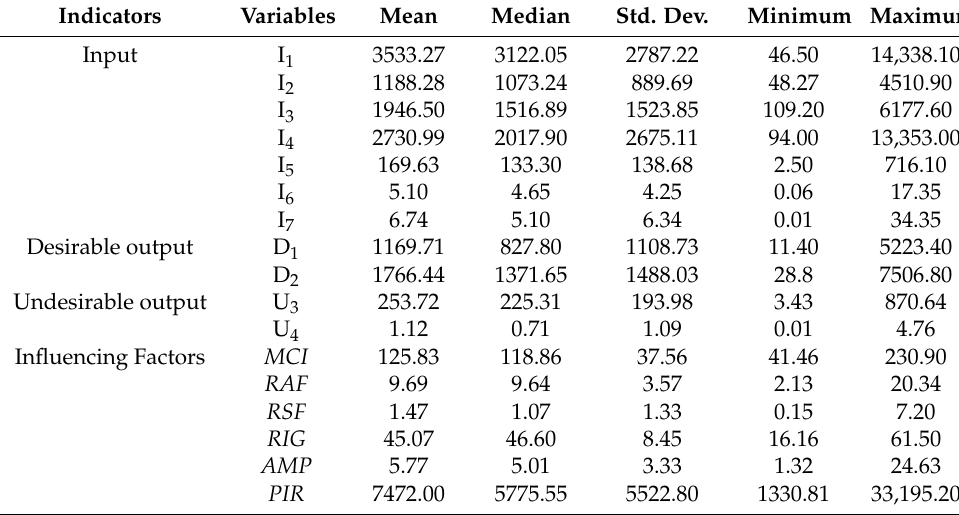
Table 5. Descriptive statistics of all